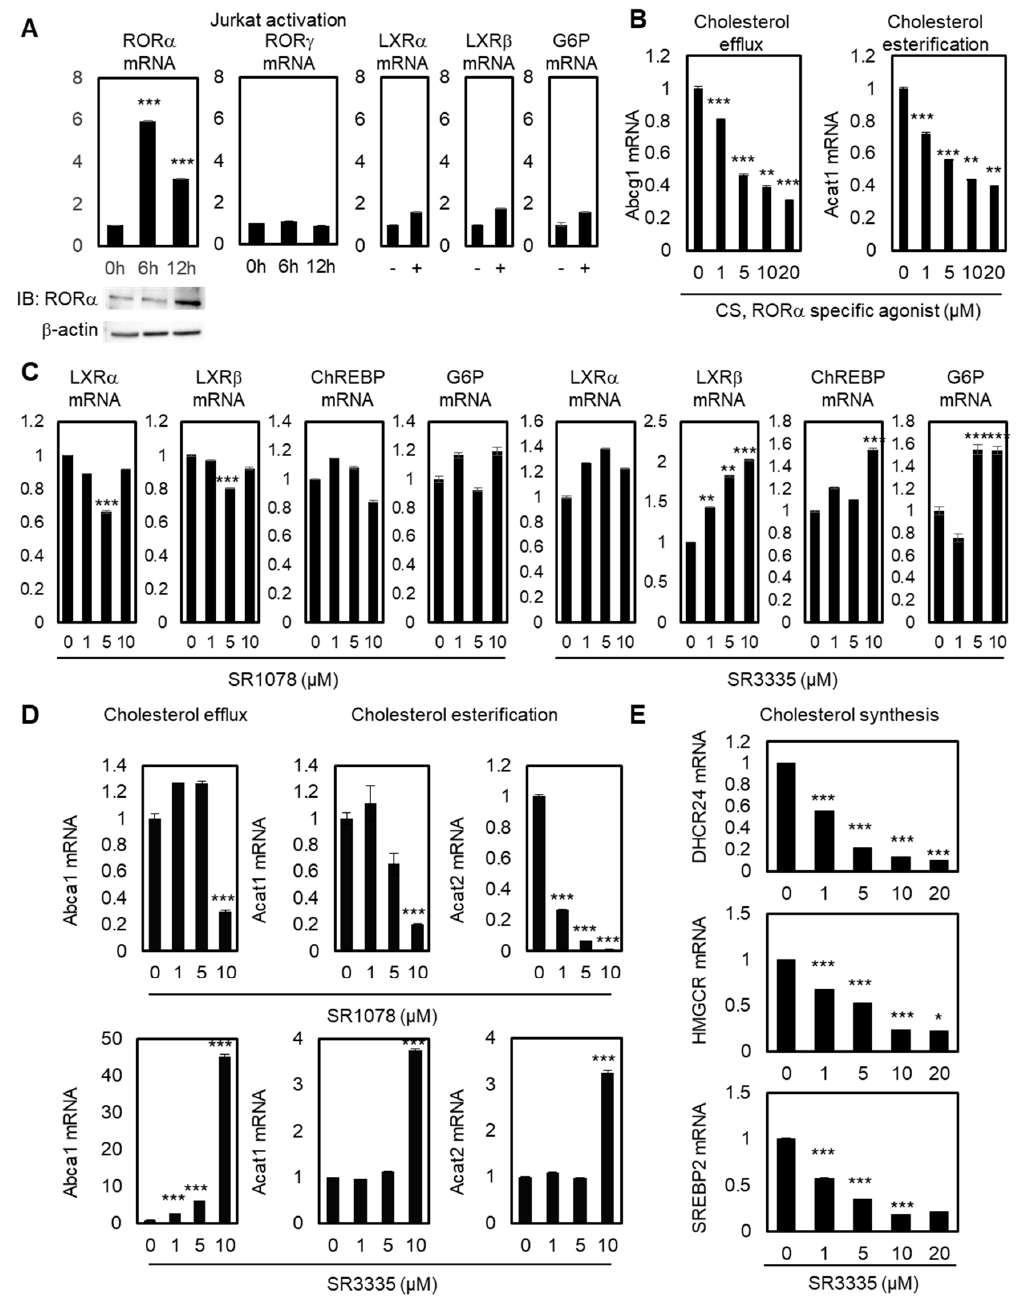
Figure 1. Increased ROR α activity is crucial for maintaining cholesterol levels in T cells. ( A ) Transcriptional levels of ROR α , ROR γ , LXR α , LXR β , and G6P in stimulated Jurkat cells by activation times (+: 24 hours). Protein levels of ROR α were detected by immunoblot analysis in stimulated Jurkat cells. The p -value was calculated by a t -test (*** p < 0.001). ( B ) Transcriptional levels of Abcg1 and Acat1 mRNAs in Jurkat cells treated with CS. The p -value was calculated by a t -test (** p < 0.01, *** p < 0.001). ( C ) Transcriptional levels of LXR α , LXR β , ChREBP, and G6P in Jurkat cells treated with SR1078 or SR3335. The p -value was calculated by a t-test (** P < 0.01, *** P < 0.001). ( D ) Transcriptional levels of Abca1 , Acat1, and Acat2 in Jurkat cells treated with SR1078 or SR3335. The p -value was calculated by a t -test (*** p < 0.001). ( E ) Transcriptional levels of cholesterol synthesis genes DHCR24 , HMGCR , and SREBP2 in Jurkat cells treated with CS. The p -value was calculated by a t -test (* p < 0.05, *** p < 0.001).